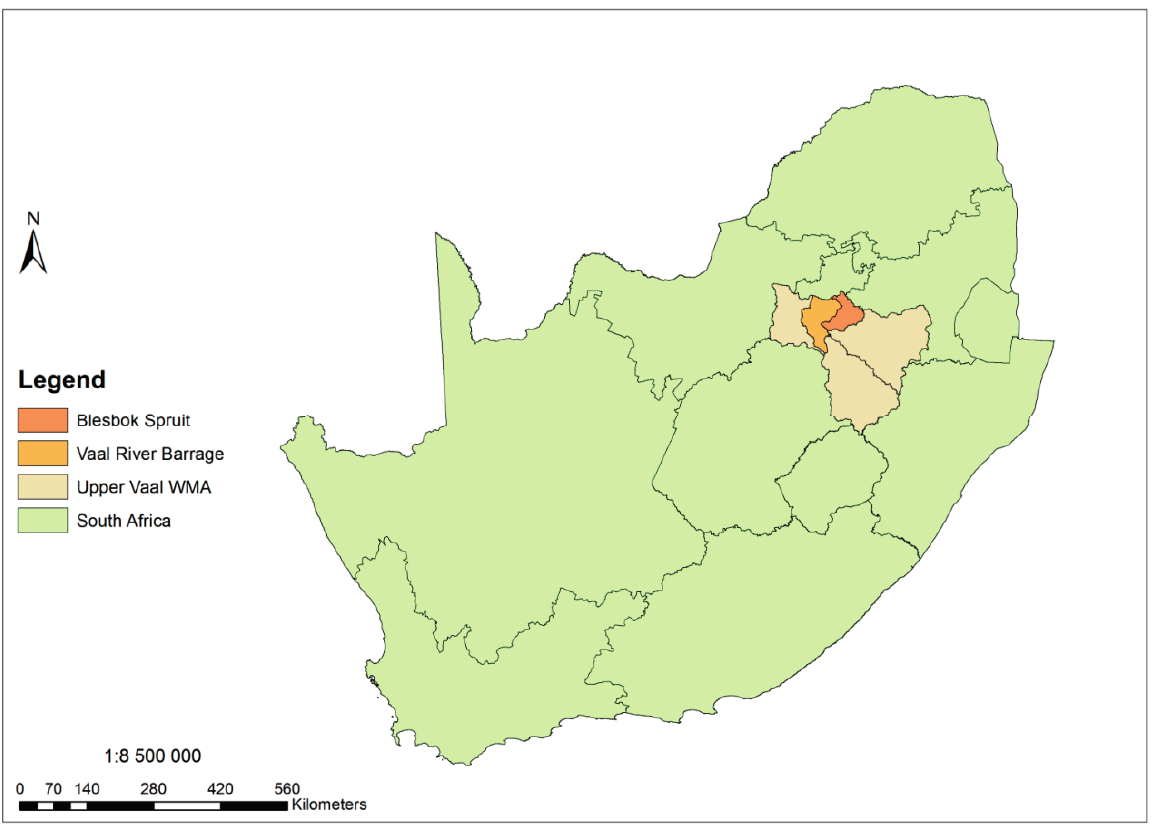
Figure 1. Location of the Blesbok Spruit Catchment within South